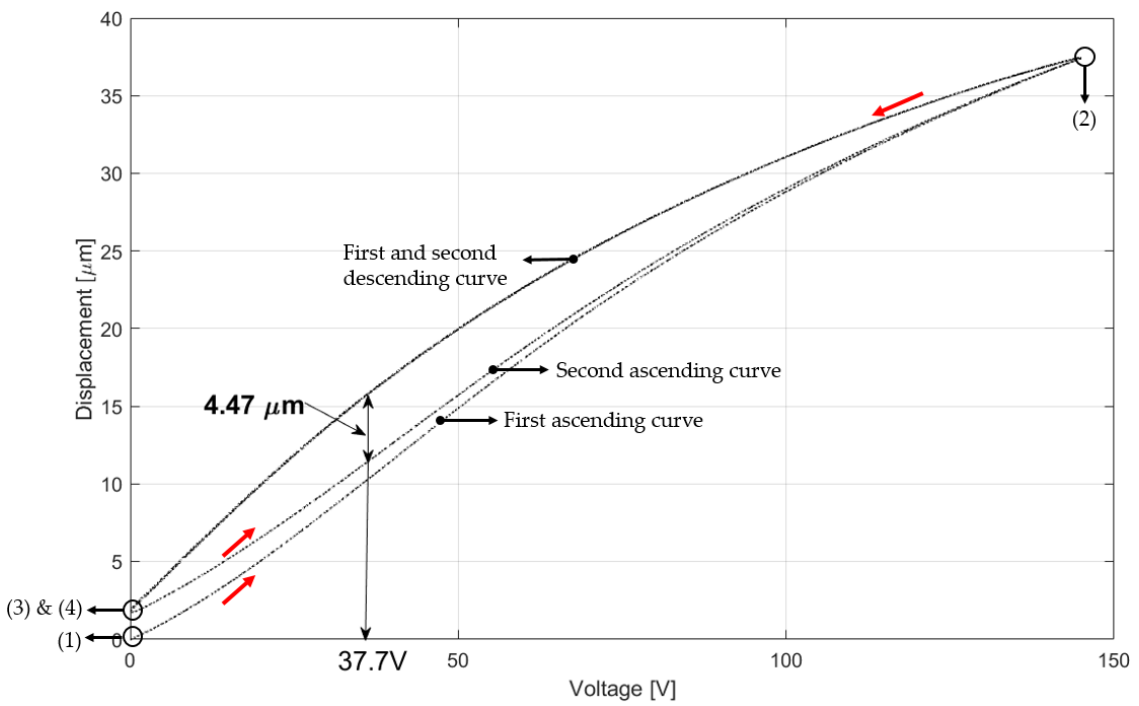
Figure 3. PK4FYC2 hysteresis graph between 0–145